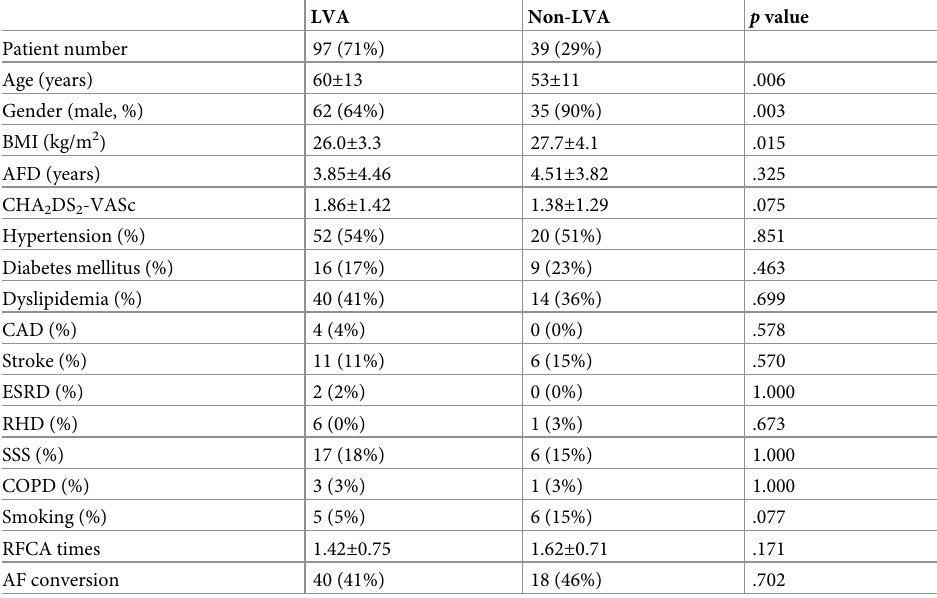
Table 5. Baseline characteristics, clinical data, and ablation results of the LVA-and non-LVA guided linear abla- tion groups.